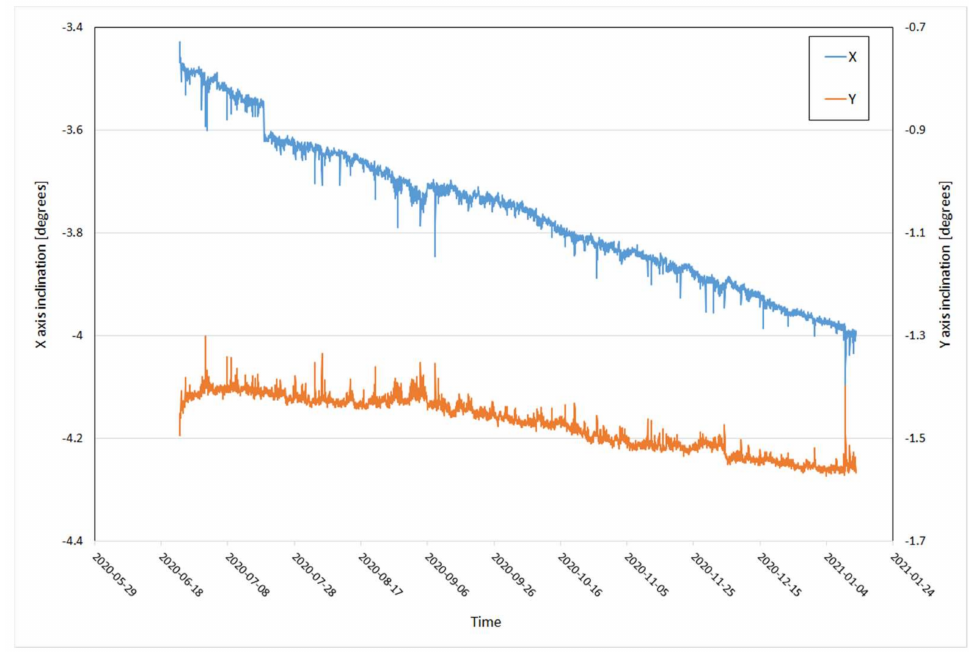
Figure 15. Changes in the slope (X and Y components) recorded by the CNS 218 sensor in the SI-XI/4